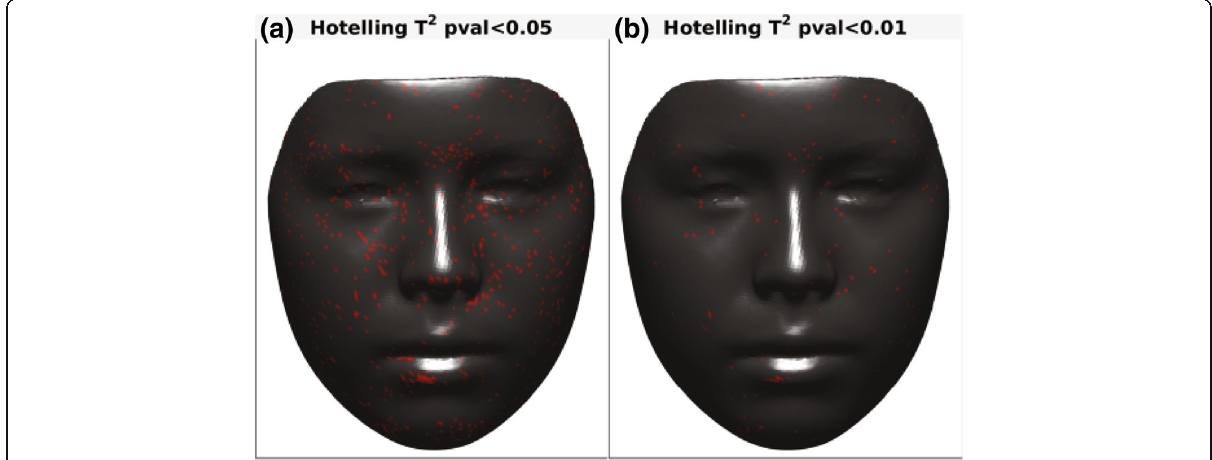
Fig. 8 P-map illustration for comparison of T1 (immediately after expansion) – T2 (retention, 1 year after termination of expansion) time points with p < 0.05 ( a ) and p < 0.01 ( b